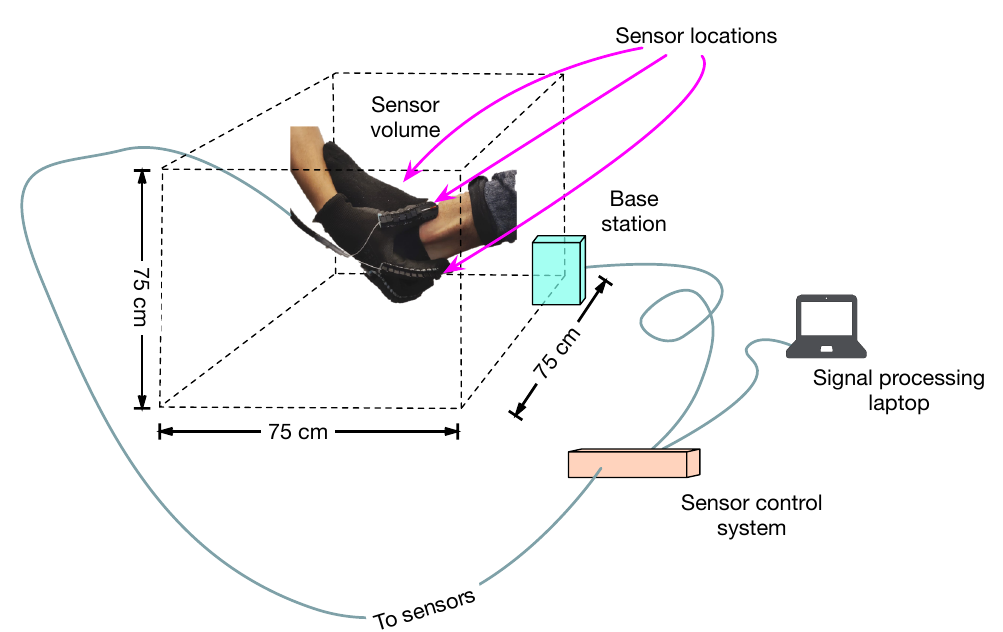
Figure 1. Ilustration of the physical setup. All measurements are referenced to the center point of the base station (light blue). The base station and sensors are connected to a control system (tan box) via cables. The sensors are mounted in a glove as shown, and at the location indicated on the foot (sensor not shown). The sensor volume is given by the dashed lines. The sensor data is processed by a computer for real time display.